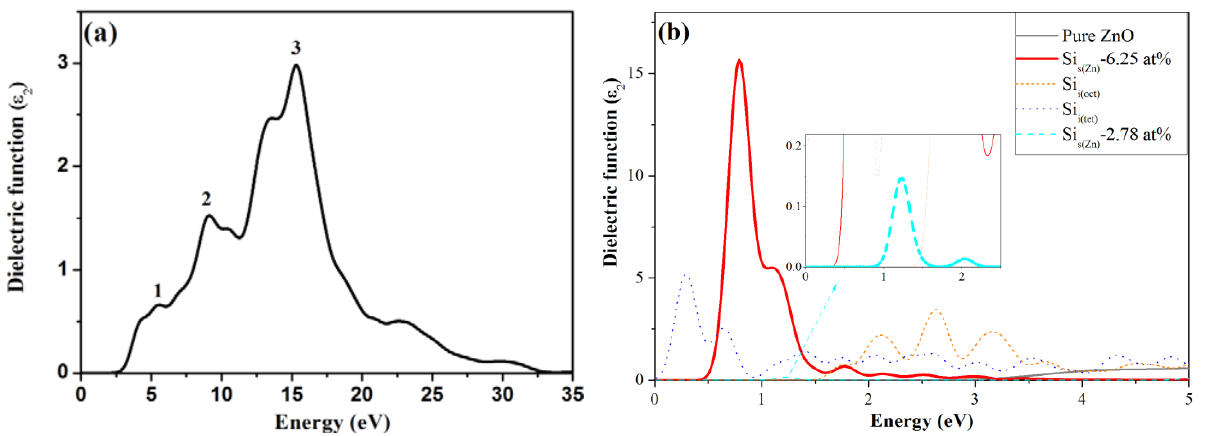
Figure 8. Transmittance spectra of pure ZnO and various Si doping